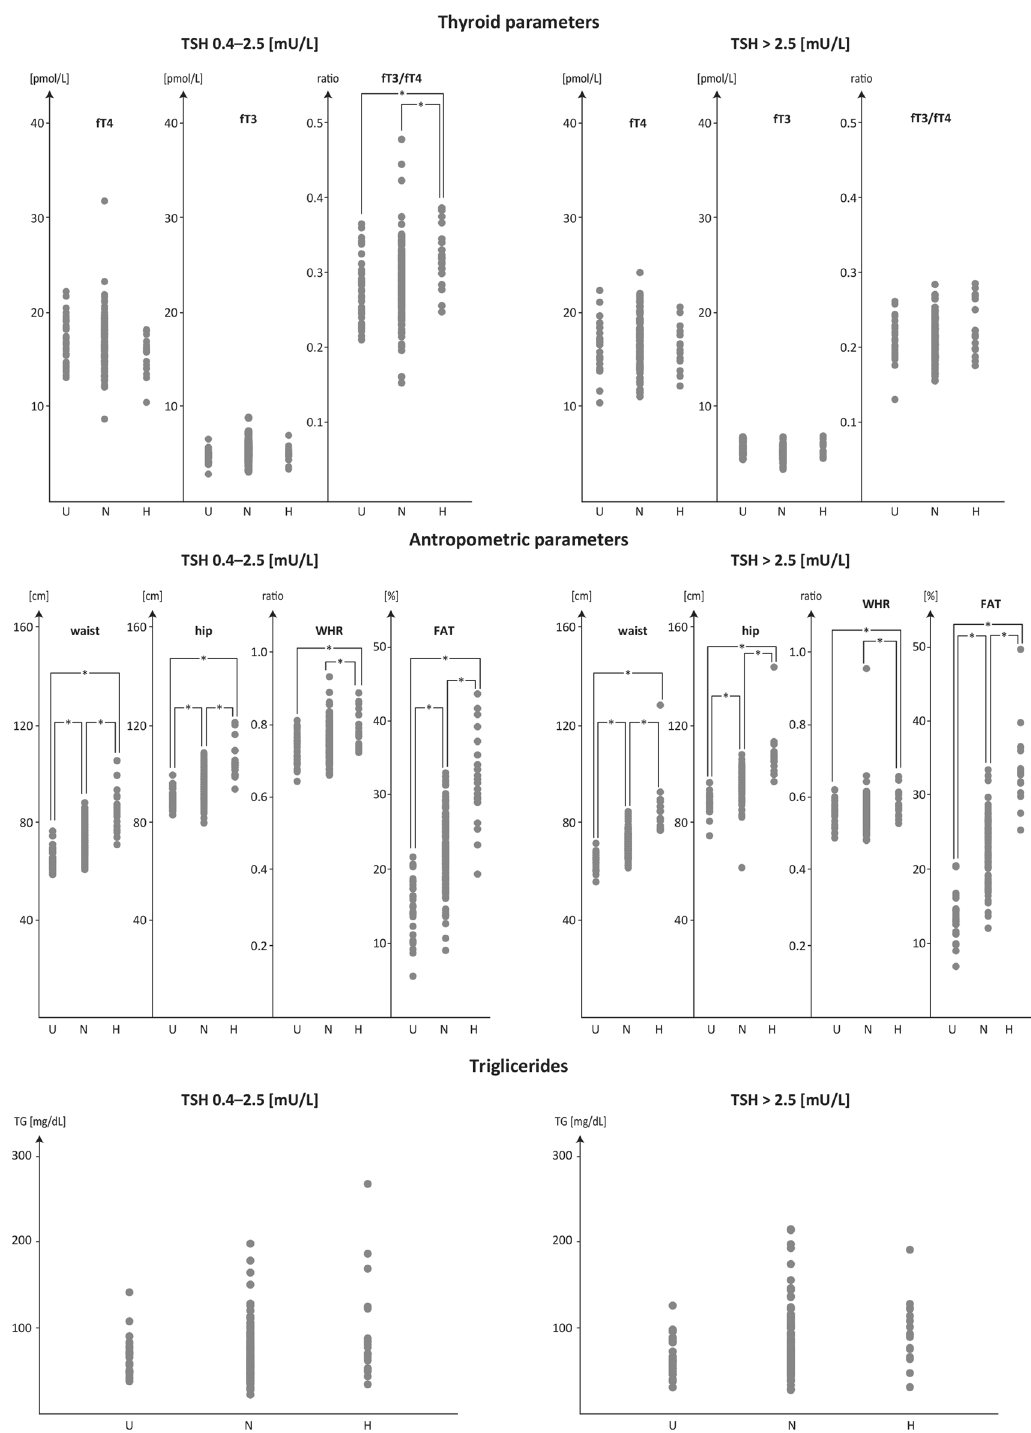
Figure 2. Effects of TSH > 2.5 mU/L on serum concentrations of thyroid hormones (fT4, fT3, fT3/fT4), anthropometric parameters (waist circumference, hip circumference, WHR, FAT%) and serum triglyceride